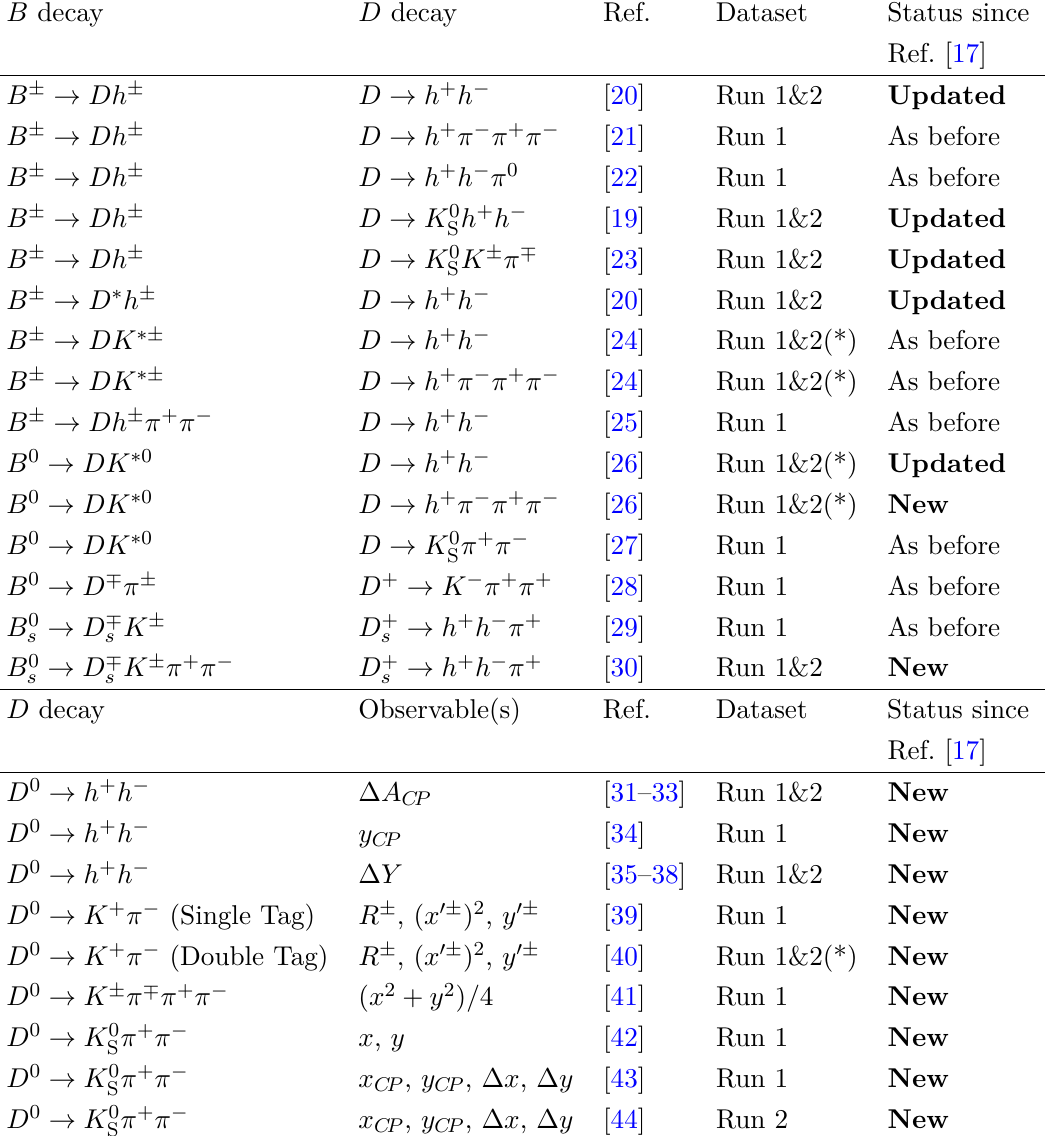
Table 1 . Measurements used in the combination. Inputs from the charm system appear in the lower part of the table. Those that are new, or that have changed, since the previous combination [17] are highlighted in bold. Measurements denoted by (*) include only a fraction of the Run 2 sample, corresponding to data taken in 2015 and 2016. Where multiple references are cited, measured values are taken from the most recent results, which include information from the others.